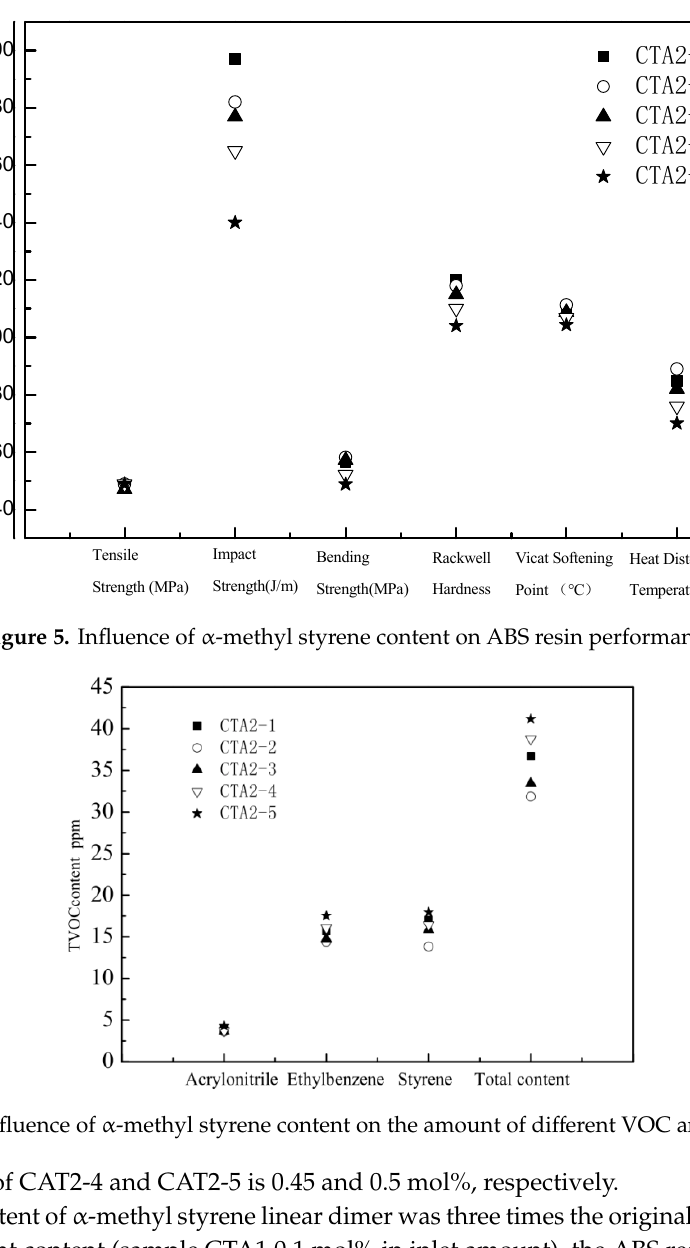
Figure 6. Influence of α -methyl styrene content on the amount of different VOC and on TVOC.